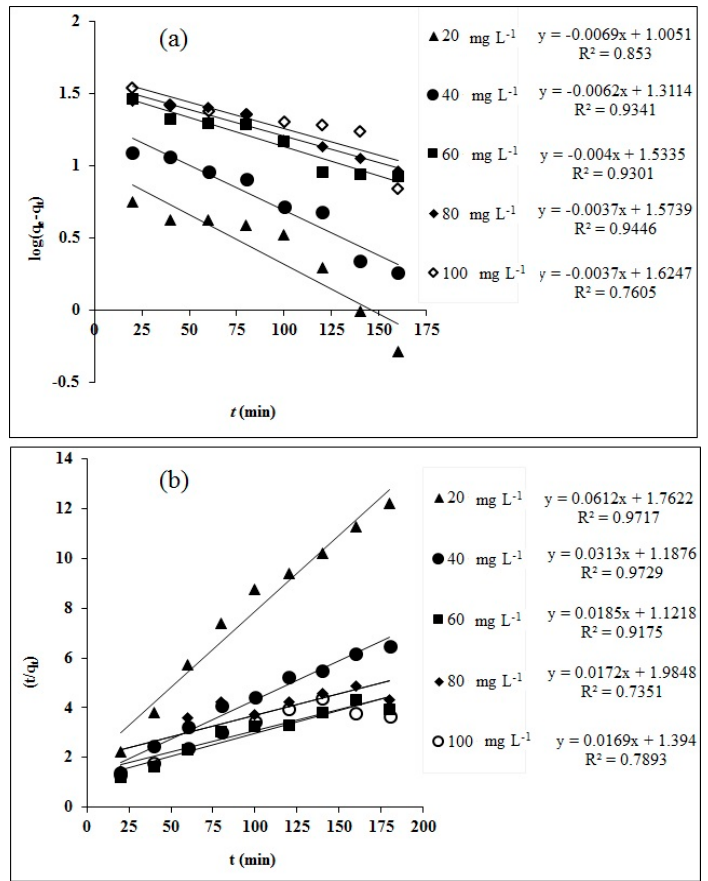
Figure 10. Linear kinetic fitness for RO16 adsorption onto MA-AC400: ( a ) PFO kinetic plot; ( b ) PSO kinetic plot.